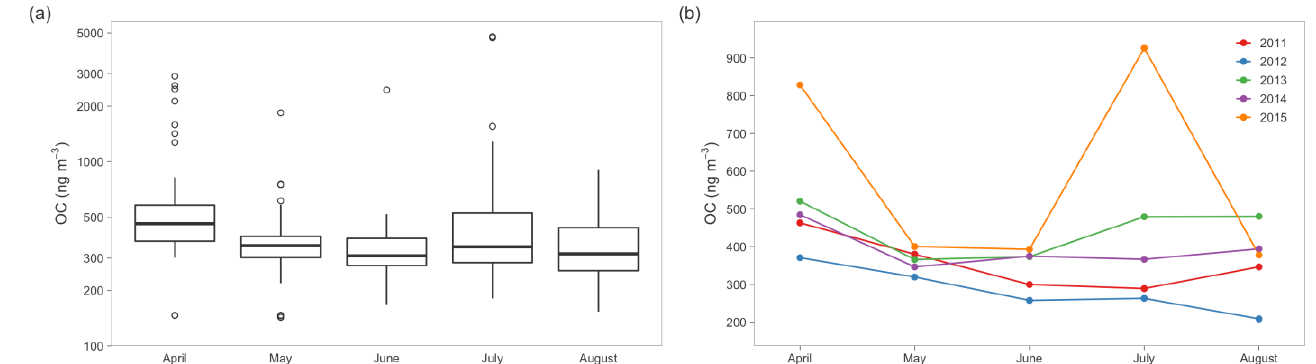
Figure 5. ( a ) OC variation of average monthly concentrations. Y -axes is represented in log 5 to show all the outliers. ( b ) OC variation of average monthly concentrations for every single year. Whisker plot ( a ) shows the IQR as a box (divided by a horizontal line representing the median) and the distance 1.5*IQR as whiskers; black circles are the data outliers, that is, the data that do not fall inside the previous categories.